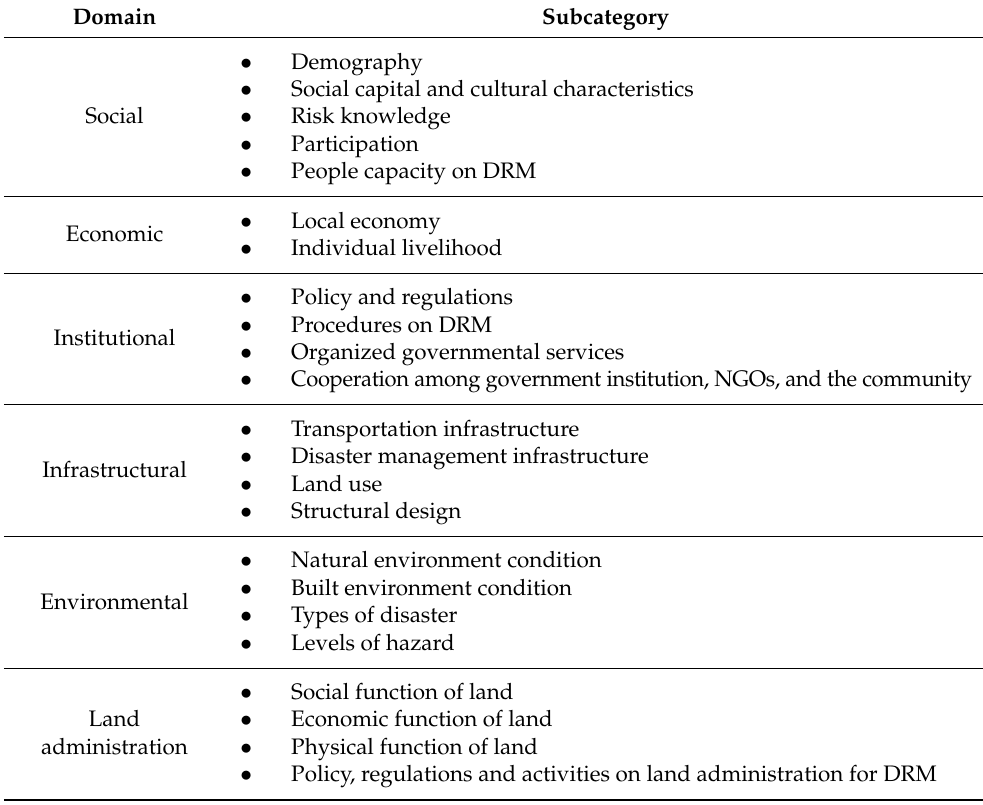
Table 2. Domains and subcategories of community disaster resilience